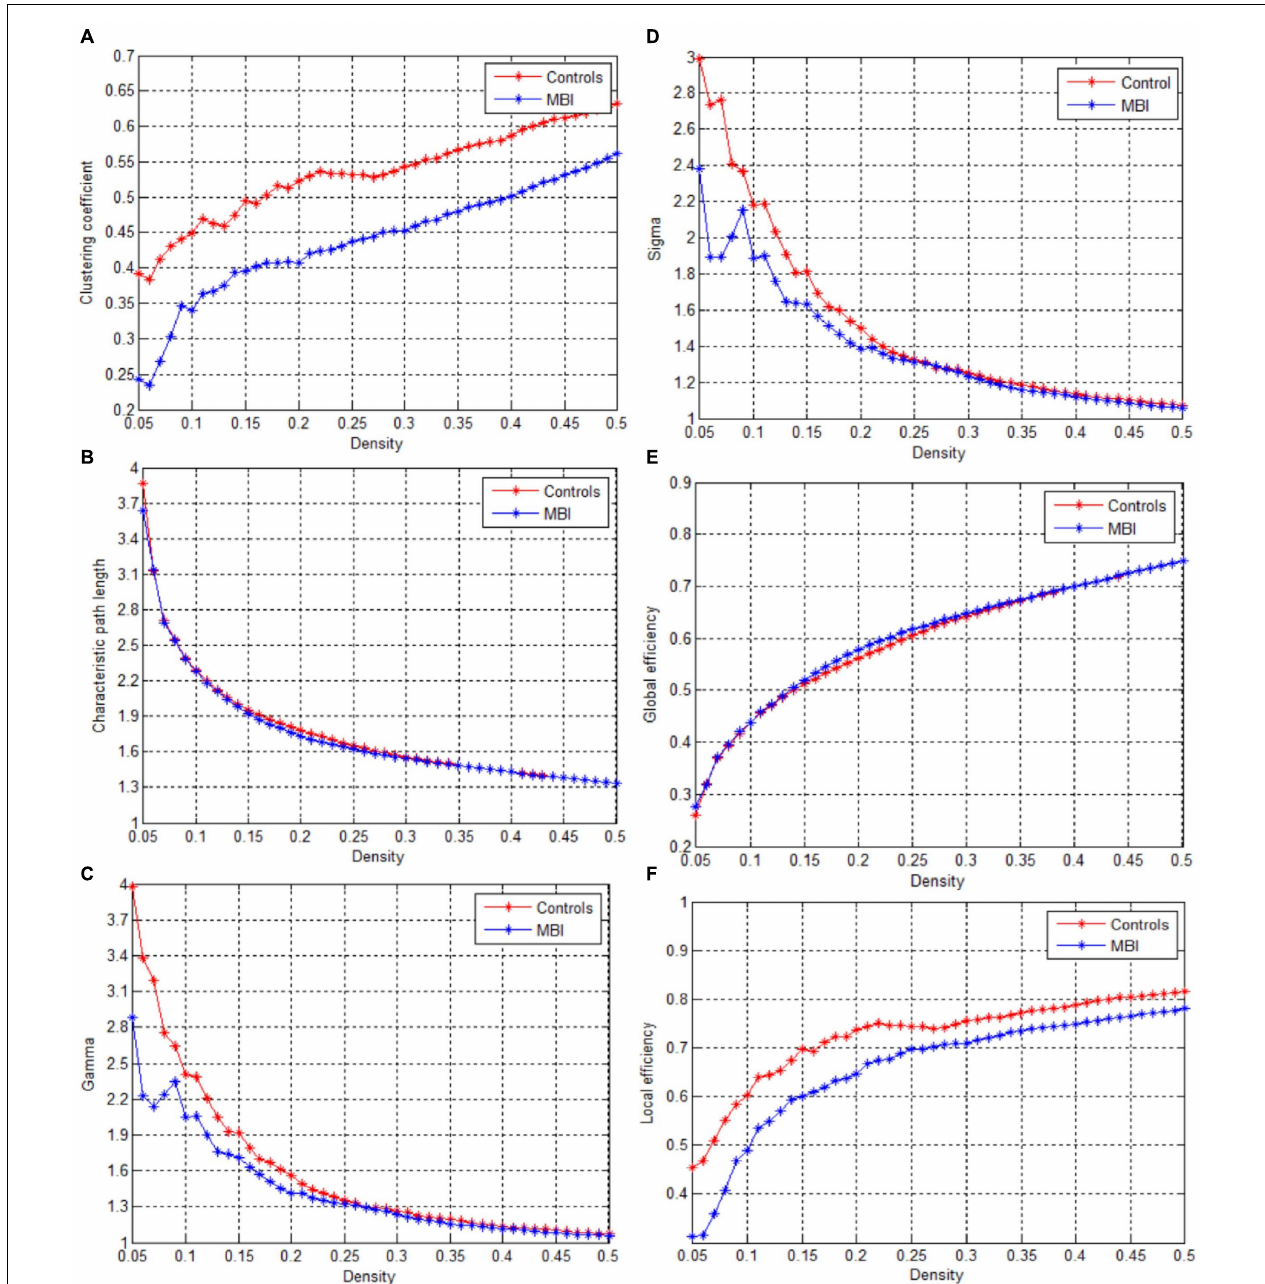
FIGURE 1 | Changes in global network parameters as a function of network density. (A) Clustering coefficient, (B) Characteristic path length, (C) Gamma, (D) Sigma value, (E) Global efficiency, (F) Local efficiency in normal controls (controls) and MBI